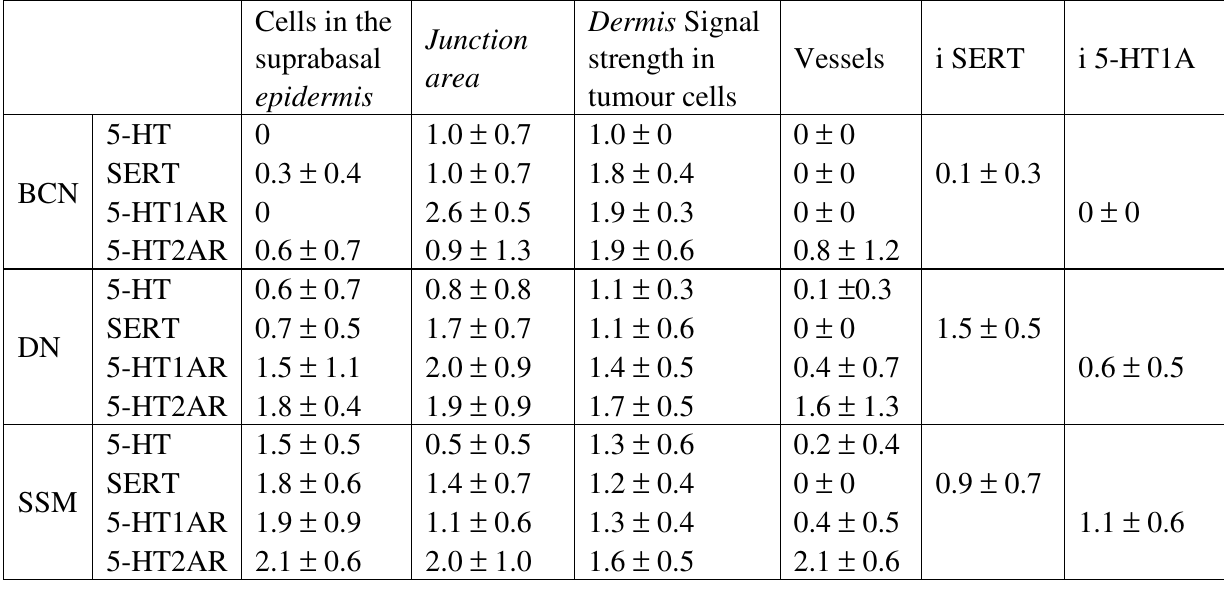
Table 1. Expression of 5-HT, SERT, 5-HT1AR and 5-HT2AR in BCN, DN and SSM. Cells in